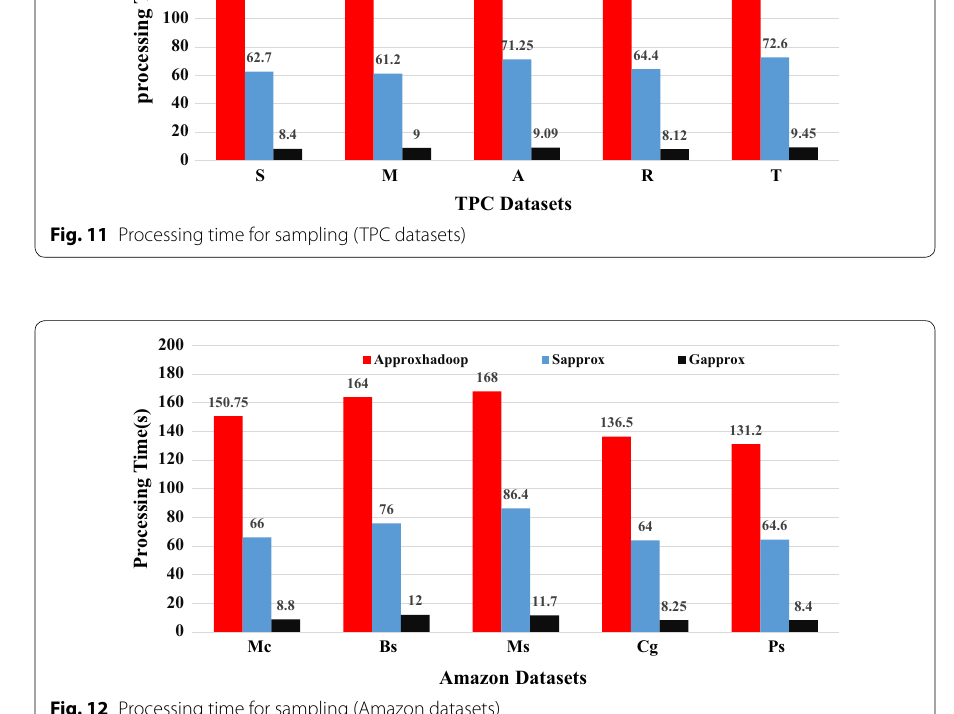
Fig. 12 Processing time for sampling (Amazon datasets)